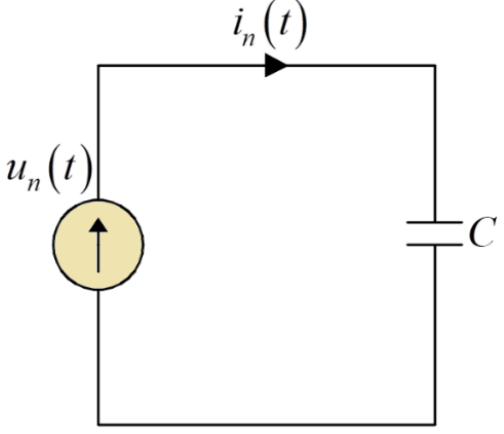
Figure 7. Scheme of the single-phase system used for theoretical calculations. Table 8. List of complex values of currents in CPC theory.